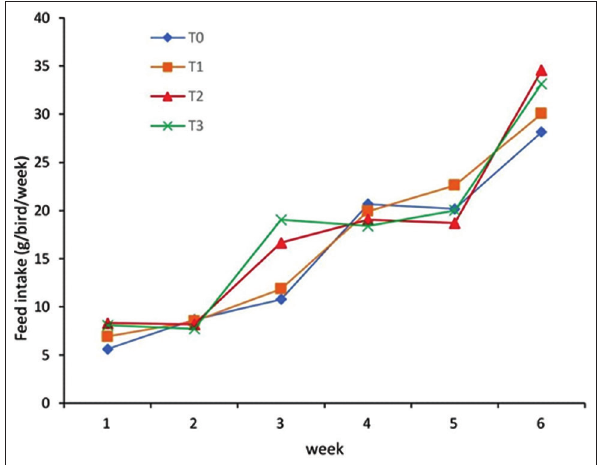
Figure-2: Relationship between diet treatment and feed intake of native chickens during the starter phase (1-6 weeks).